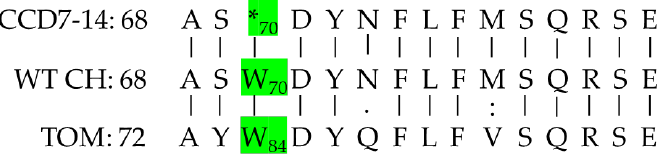
Figure 4. The Blast results of DNA sequences (nucleotides 202–246) of WT F01 chickpea (upper line) and CCD7M14 (lower line). The G-to-A transition at position 210 is indicated in bold red letters.